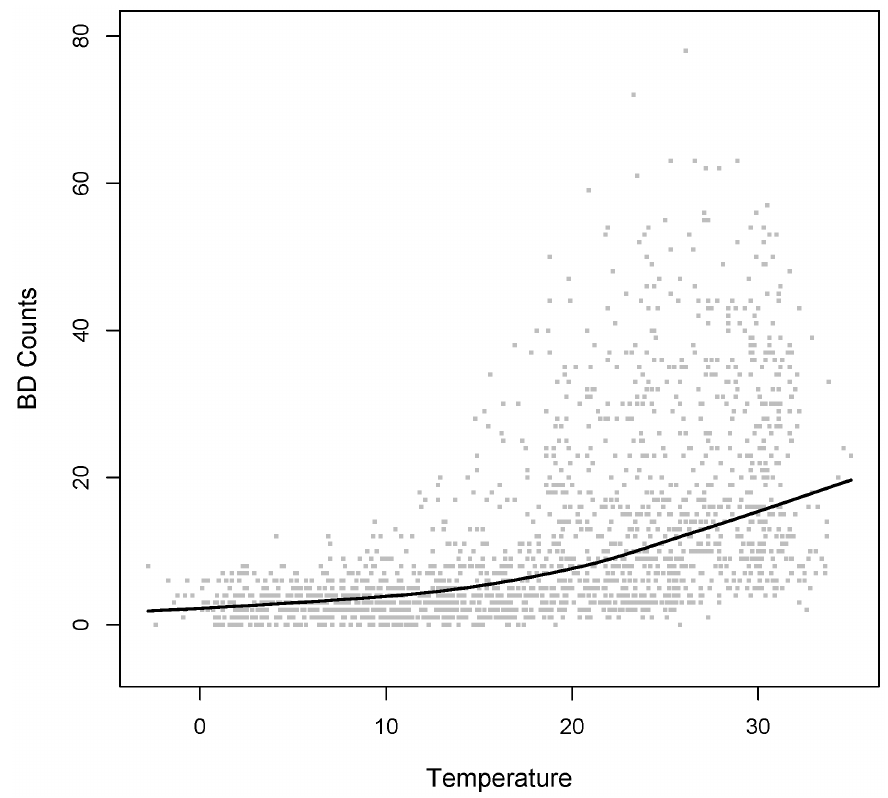
Figure 2. Scatter plot of BD counts vs. Temperature from 2004 to 2008. The solid black line is the Lowess estimator of the association between daily BD counts and daily average temperature.